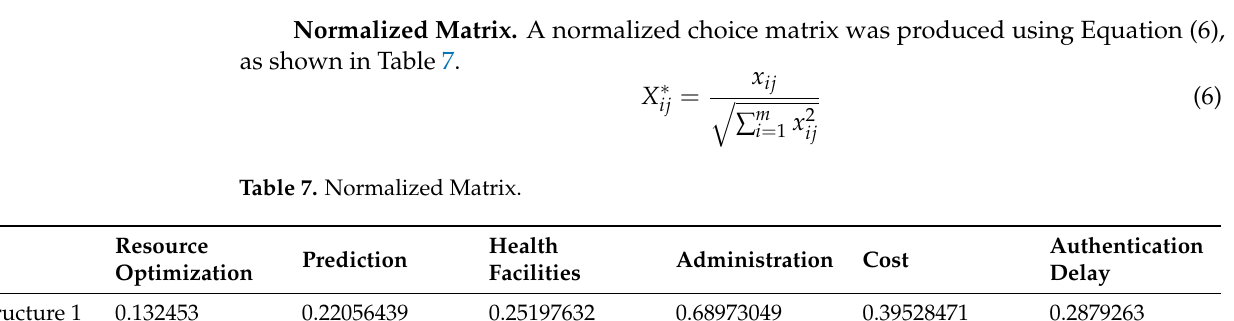
Table 7. Normalized Matrix.